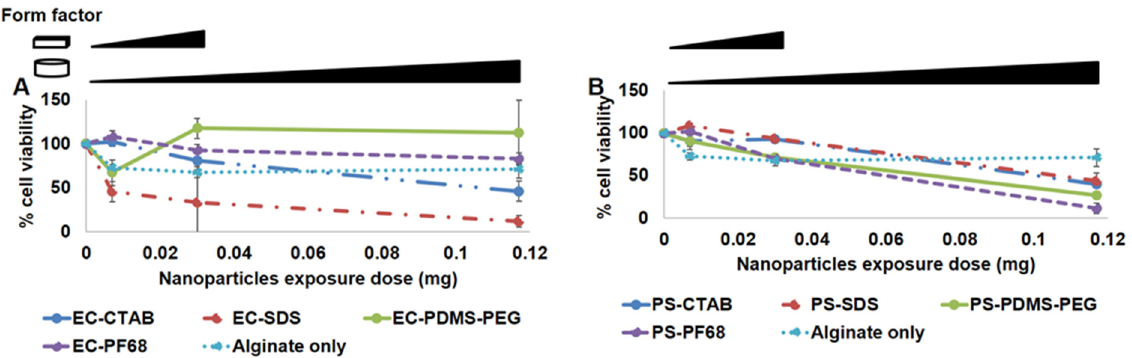
Figure 6. Panel ( A ) Cell viability in presence of ethyl cellulose NPs and ( B ) polystyrene NPs, encapsulated in alginate microspheres.